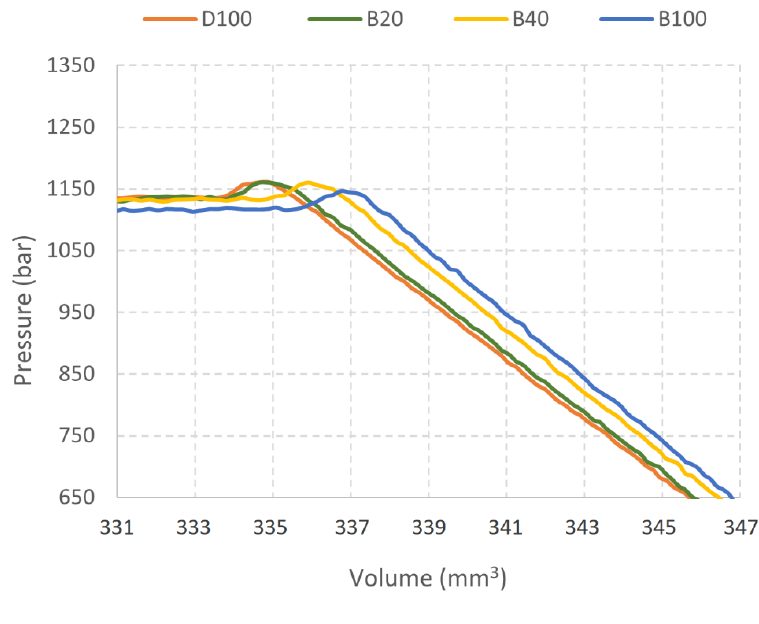
Figure 13. PWC diagrams for pure fluids and blends at 3000 RPM, MP. At low speed, 1500 RPM (Figure 14a,b), more regular trends are found in each phase (as already discussed above). In the compression phase (Figure 14b), the pressure trends clearly reflect the blend, with B20 and B40 clearly distinct and placed at intermediate positions between the pure fluids D100 and B100.